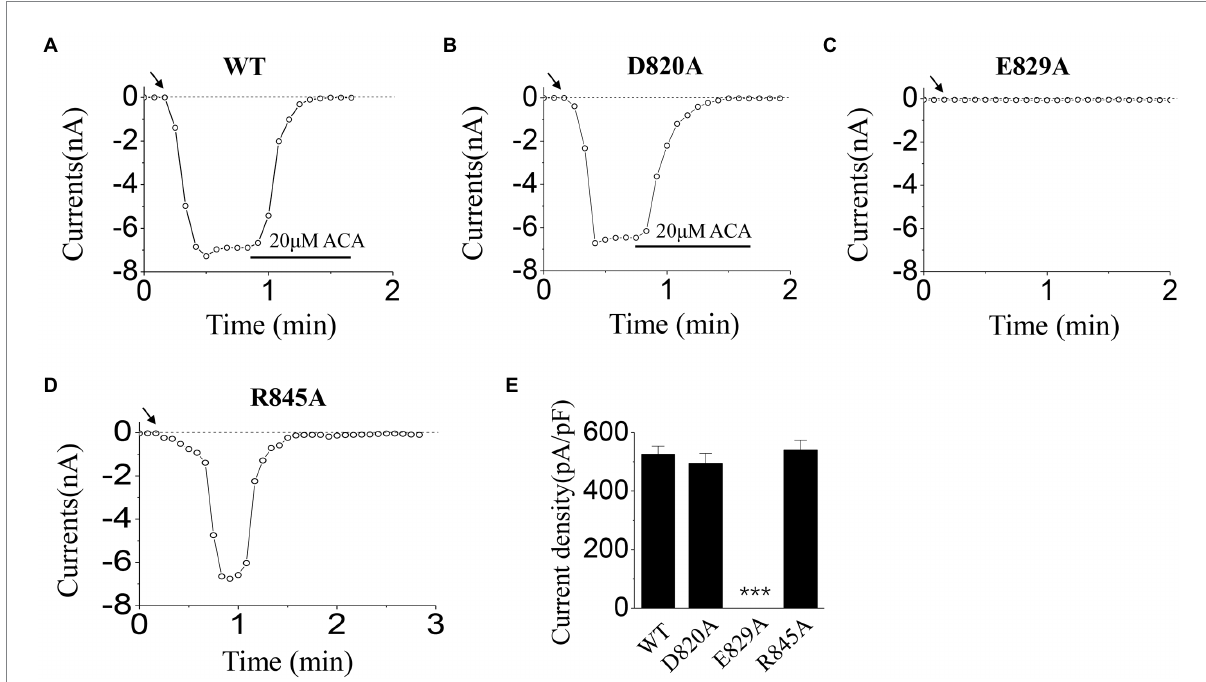
FIGURE 3 Functional assay of WT TRPM2 and its alanine mutants. (A–D) Representative whole-cell recordings of TRPM2 channel currents induced by ICS of 500 μ M ADPR from HEK293T cells expressing (A) WT, (B) D820A, (C) E829A, and (D) R845A. The arrow in each panel indicates the time point at which whole cell configuration was established. (E) Summary of the current density induced in cells expressing WT and the mutants. In each case, six cells were tested. *** p < 0.001 compared with